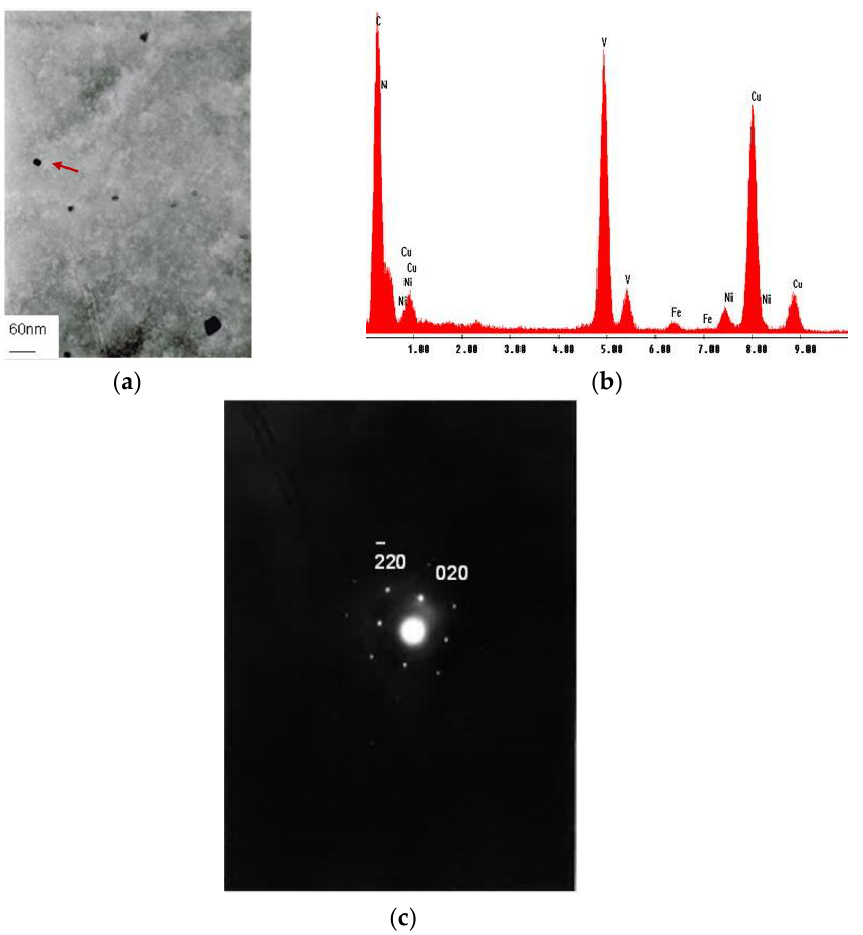
Figure 6. TEM images of steel used. ( a ) Image showing precipitates for specimen tested at reheating temperature of 1200 °C/10 min; Def. temp.= 900 °C; strain = 0.35; strain rate = 3.63 s −1 ; holding time = 250 s; ( b ) EDAX spectrum of precipitate; ( c ) Electron diffraction image.